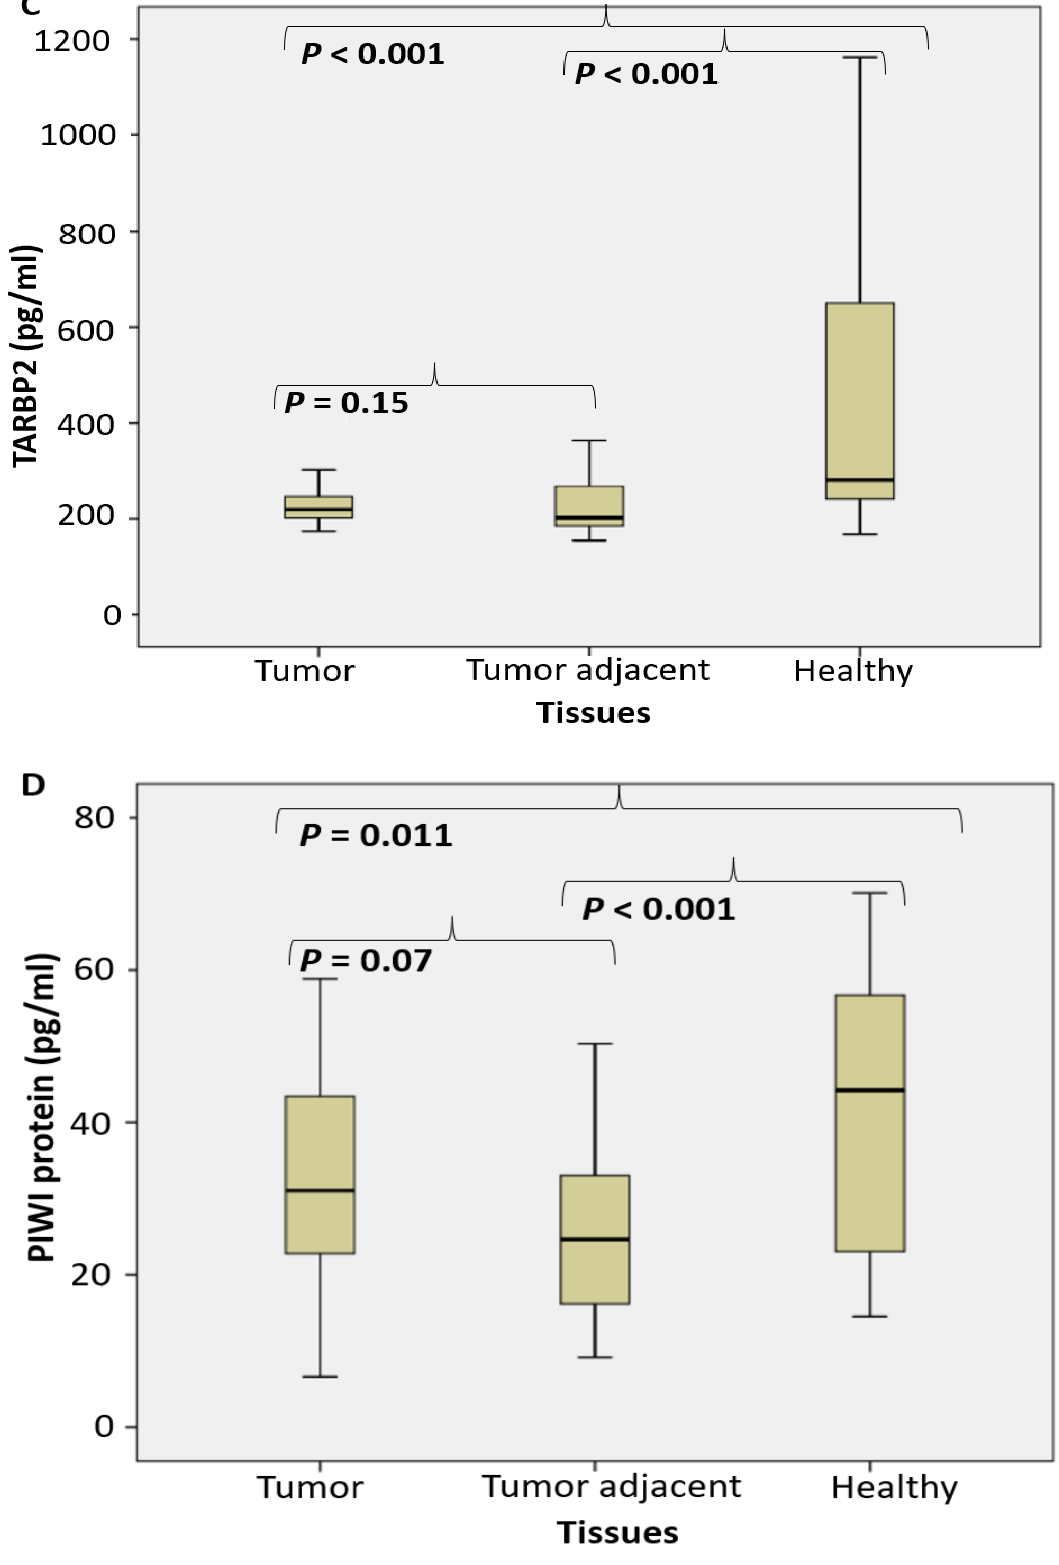
Figure 3. The level of NF- κBp65 and the miRNA/piRNA assembled proteins shift in tumor adjacent tissue of PC. (NF- κB p65 ( A ), argonaut protein AGO2 ( B ), TARBP2 ( C ) and PIWI protein (pg/mL) ( D ) in prostate cancer, tumor adjacent and healthy tissue, accordingly).